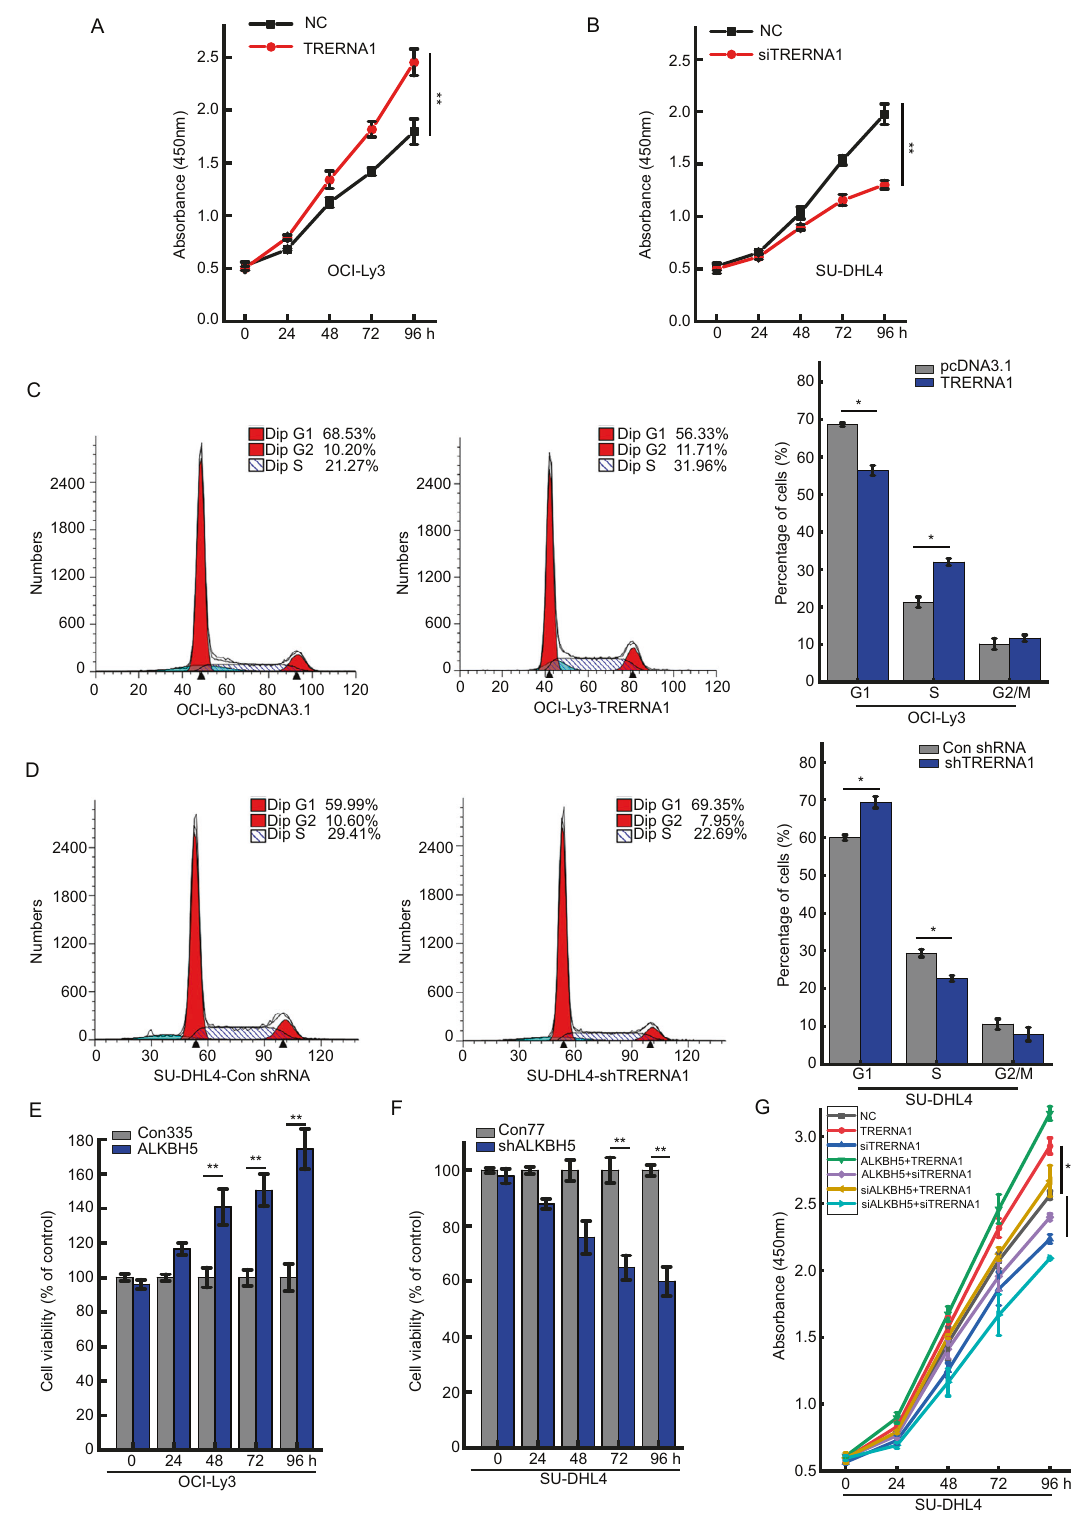
Fig. 2 ALKBH5-mediated regulation of TRERNA1 promotes cell proliferation and cell cycle progression in DLBCL. A TRERNA1 overexpression promoted cell proliferation, as determined by the CCK-8 assay. B TRERNA1 silencing suppressed cell proliferation, as assessed by CCK-8 assay. C TRERNA1 accelerated cell cycle progression at the G1/S phase in OCI-Ly3 cells as determined by fl ow cytometry. D TRERNA1 silencing induced cell cycle arrest at G1/S phase in SU-DHL4 cells, as assessed by fl ow cytometry. E ALKBH5 upregulation enhanced the viability of OCI-Ly3 cells (Con335 is the negative control group relative to TRERNA1 overexpression). F ALKBH5 silencing decreased the viability of SU-DHL4 cells (Con77 is the negative control group relative to TRERNA1 knockdown). G Cell proliferation was assessed after the indicated transfections. The data are presented as the mean ± SD values; n = 3. * P < 0.05, ** P <